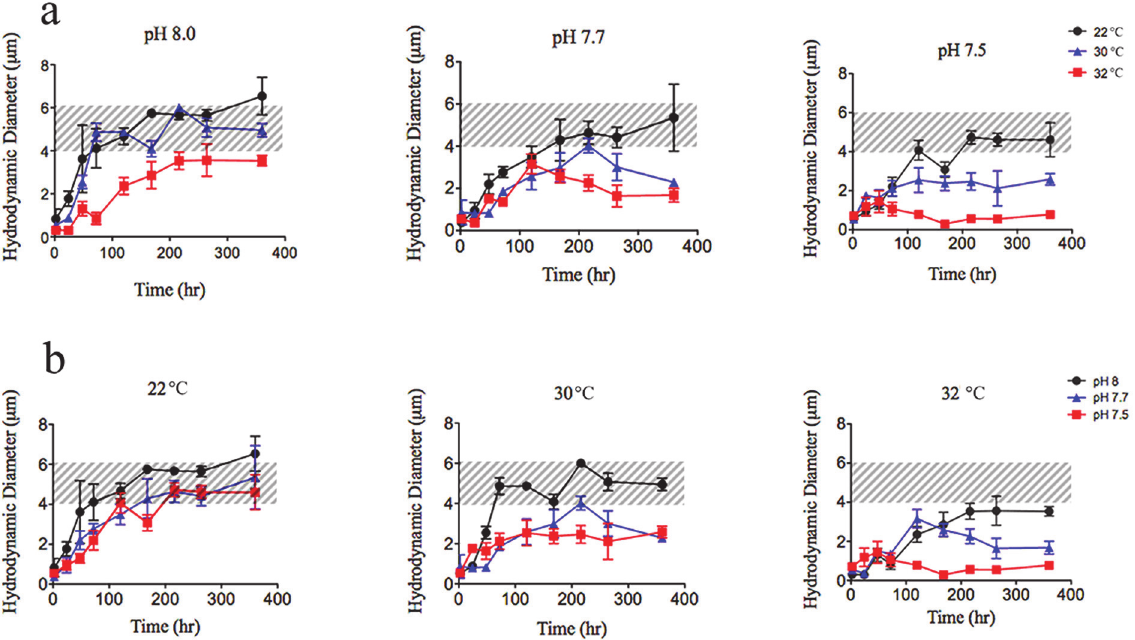
Fig 3. DOM assembly monitored with temperature and pH reveals that, as either pH decreases or temperature increases, microgel equilibrium size and assembly rates decrease at a non-linear rate. a. DOM assembly at three temperatures — 22 ˚ C (black circles), 30 ˚ C (blue triangles), 32 ˚ C (red squares) — over time at three pH units. Each data point represents (mean ± SD) of six measurements made in each of six replicate samples. b. DOM assembly at three pHs — 8.0 (black circles), 7.7 (blue triangles), 7.5 (red squares) — over time at three constant temperature incubations. Microgels assembled in identical pH conditions showed equilibrium size reduction and decelerated non-linear assembly rates when exposed to increased temperature. Each data point represents the mean (+/ − SD) of six measurements made in each of six replicate samples. Shaded windows represent an average microgel equilibrium size range (4 – 6 μ m) at 22 ˚ C and pH